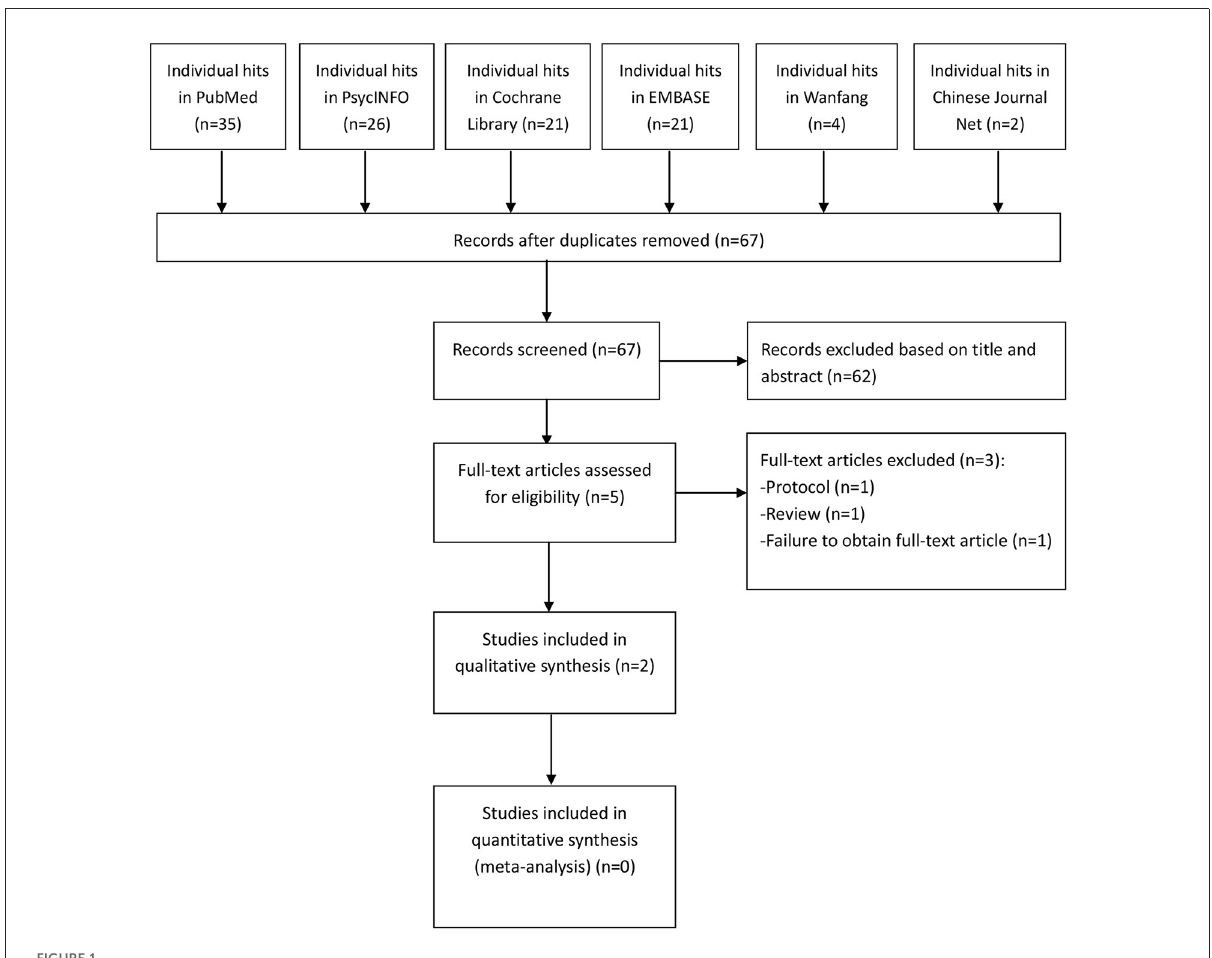
FIGURE1 PRISMA flow diagram.